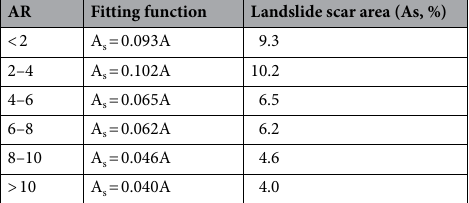
Table 1. Linear functions describing the relationships between the scar area (A s ) and the total landslide area (A), for six different classes of the aspect ratio (AR). The percentages quantify the amount of landslide scar area with respect to the total landslide area (see Supplementary Table S1).